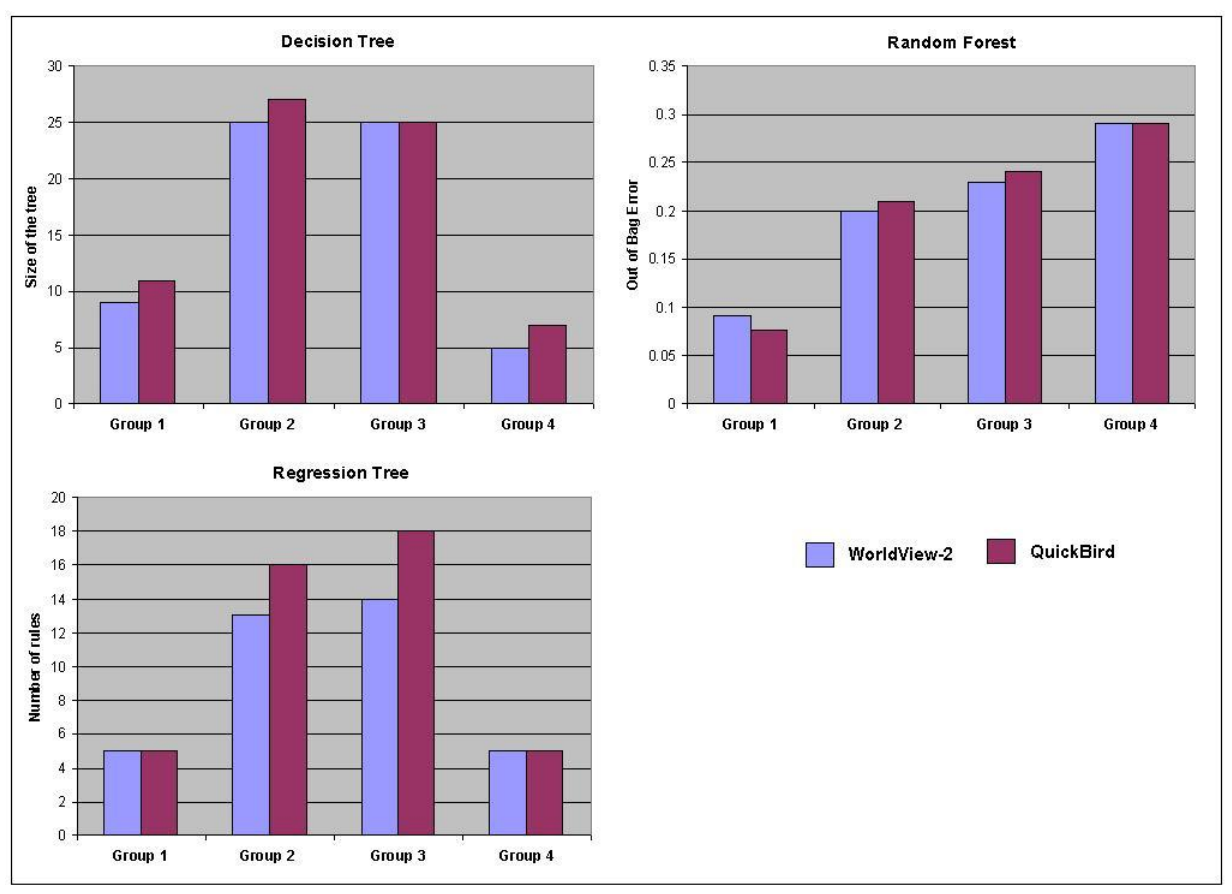
Figure 5. Comparison of the complexity and performance of the classification